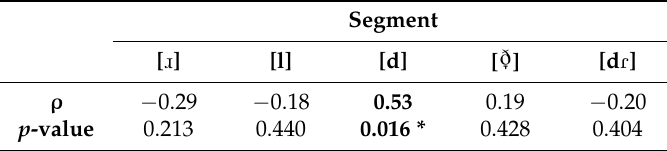
Table 3. Spearman’s rho correlations comparing L1 Mandarin–L2 English–L3 Spanish speakers’ L2 English oral proficiency with the proportion of the five most frequently produced non-native substitutions for the L3 Spanish tap